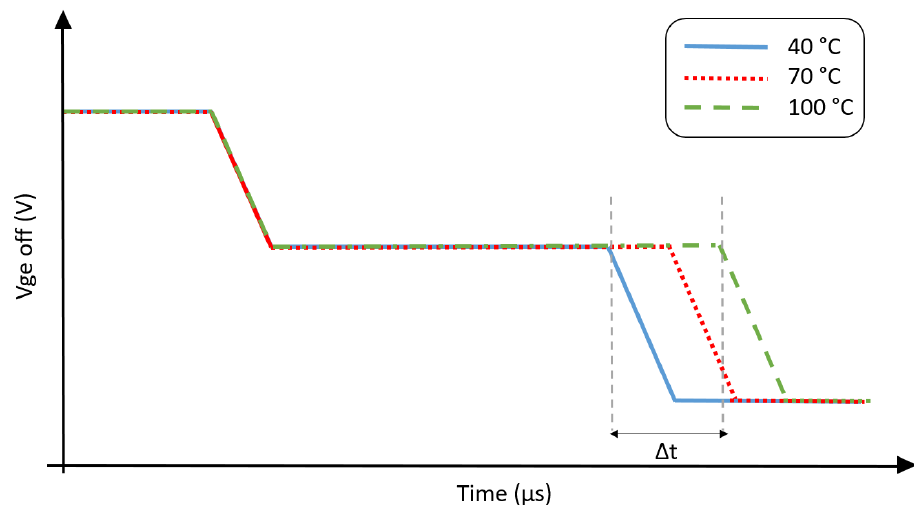
Figure 11. Simulated V ge waveform during the turn off of an IGBT by varying the temperature working operations (figure based on [110]).